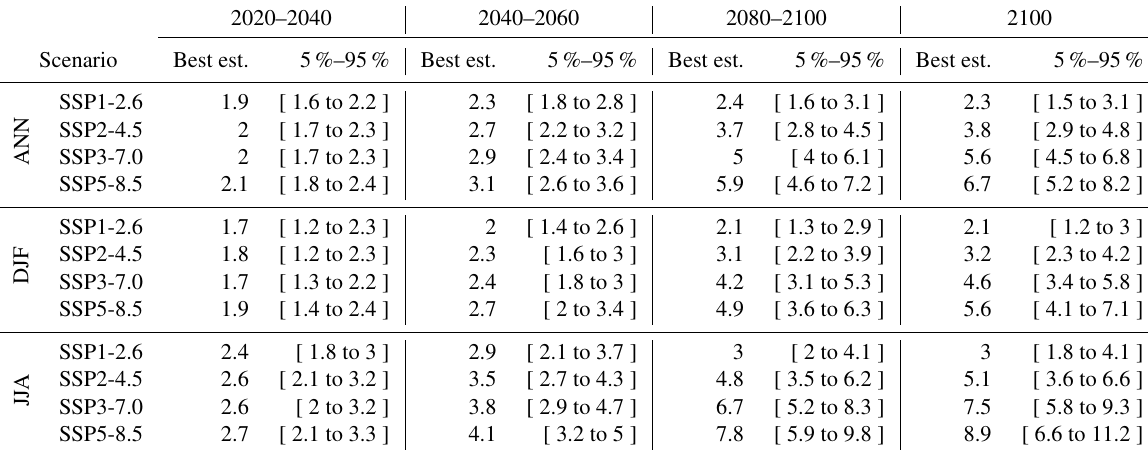
Table 1. Changes in annual mean temperature over France, assessed from CMIP6 projections constrained by both global and regional observations, for selected time periods and the four illustrative emissions scenarios considered. Temperature differences are relative to the period 1900–1930 and are reported in degrees Celsius ( ◦